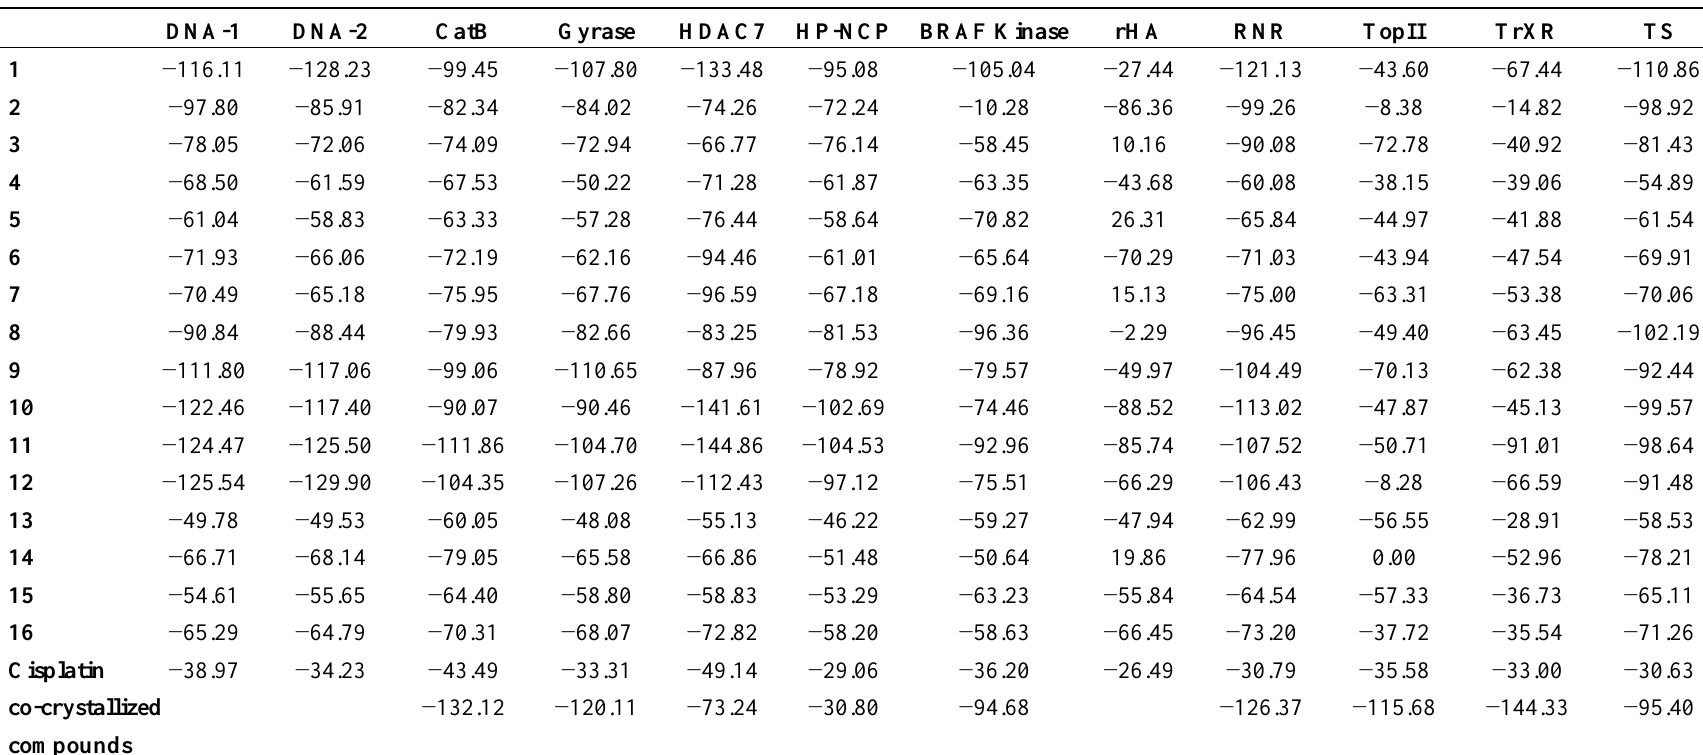
Table 6. The binding affinities of the metallocompounds from the covalent constrained Molegro docking.